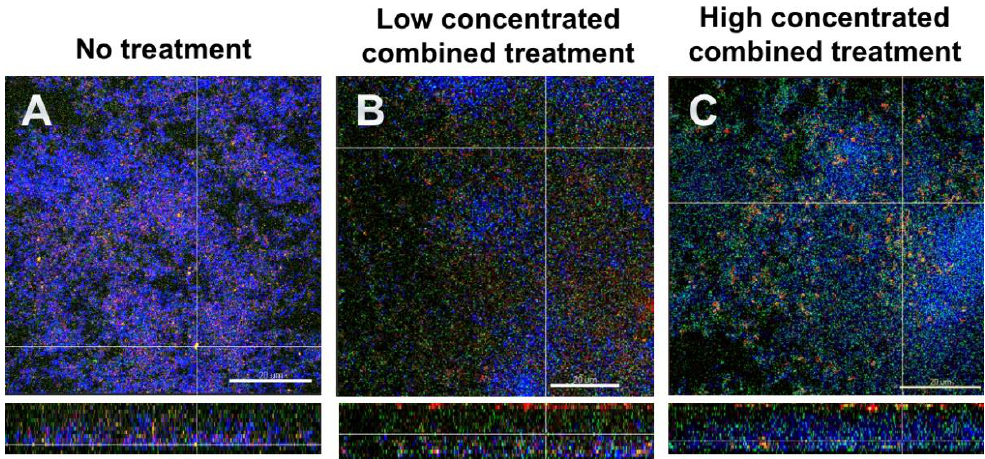
Figure 4. Representative CLSM images of six-species oral biofilms after no treatment ( A ), or combined treatment with 0.001 mg/mL DNase I and 0.05 mg/mL proteinase K ( B ), or with 0.002 mg/mL DNase I and 0.1 mg/mL proteinase K ( C ), respectively. After fluorescence in situ hybridization (FISH), microbial DNA appears blue due to DNA-staining with 4′,6-diamidino-2-phenylindole (DAPI); S. oralis is stained green with MIT447- fluorescein isothiocyanate (FITC); S. mutans appears red after staining with MUT590-Cy3; extracellular proteins appear yellow due to Sypro TM Ruby. The biofilm base in the cross sections is directed towards the top view. Scale = 20 µm.